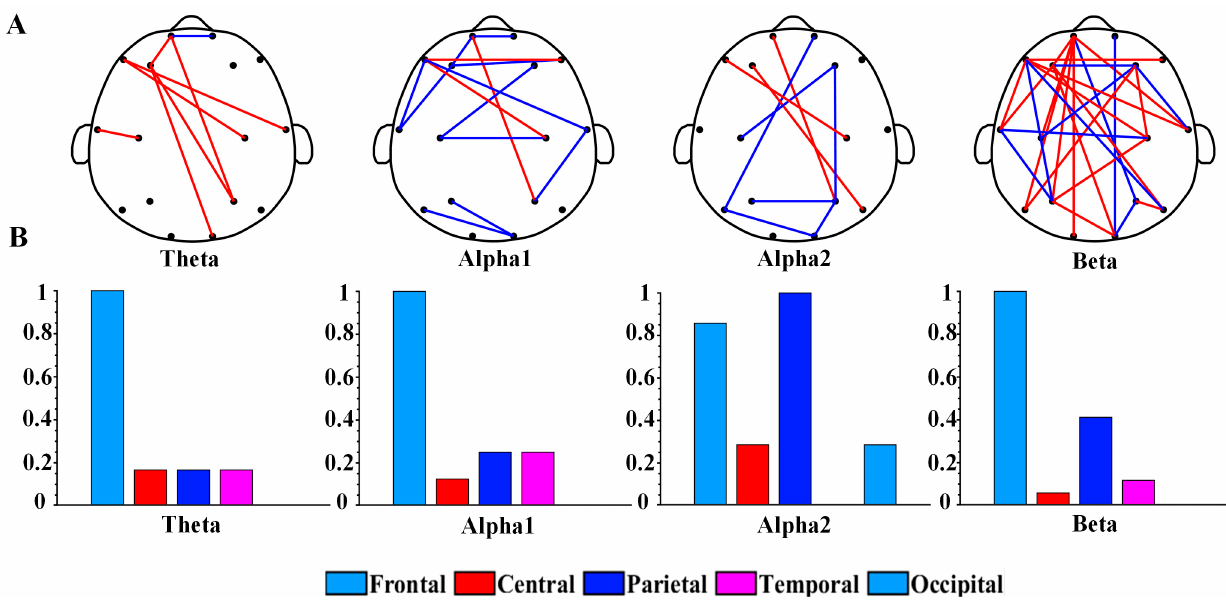
Figure 2. ( A ) Brain network topology of PLI functional connections of theta, alpha1, alpha2, and beta rhythms in optimal feature subset. The blue edges represent that the PLI values of the depression group are smaller than that of the control group, while the red edges represent that the depression group is greater than the control group. ( B ) Values after normalization of the number of functional connections in different brain regions for each rhythm. Figure 3A , B demonstrate the results of beta rhythm in PSD and FE characteristics within the optimal feature subset between the depression group and healthy controls. Compared to the healthy controls, FE and PSD had higher values in the depression group.